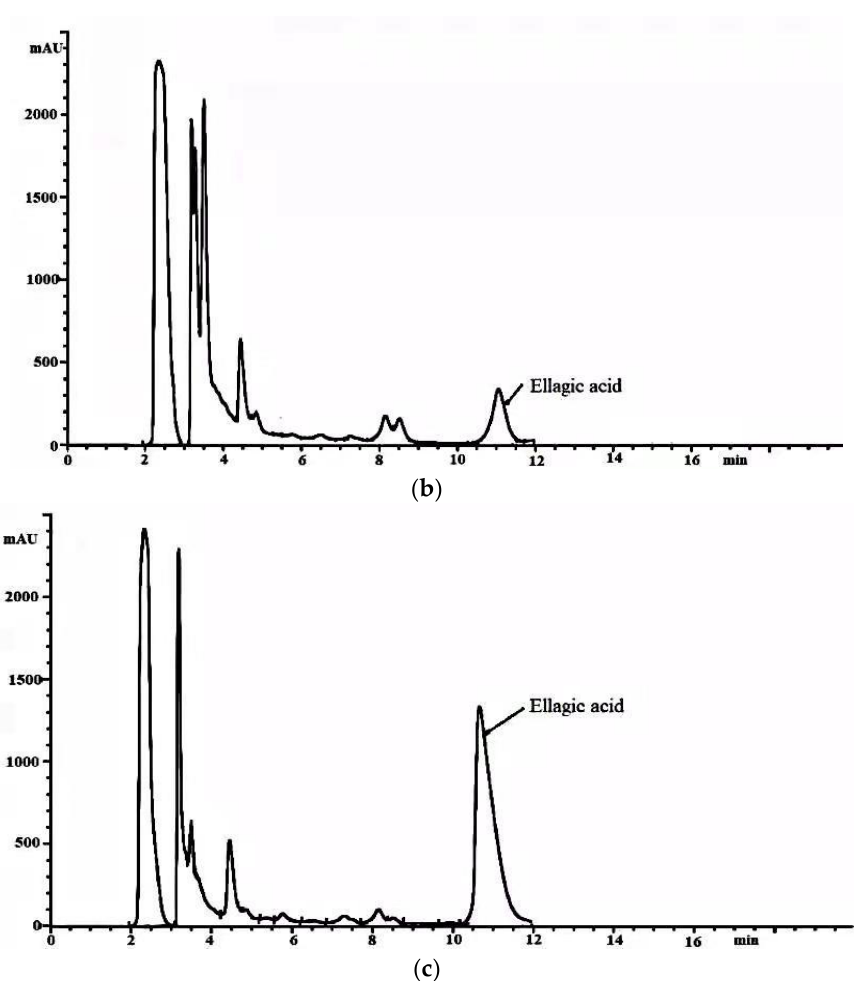
Figure 3. HPLC chromatograms of ellagic acid. ( a ) Ellagic acid standard, ( b ) ellagic acid in WE and ( c ) ellagic acid in FB.